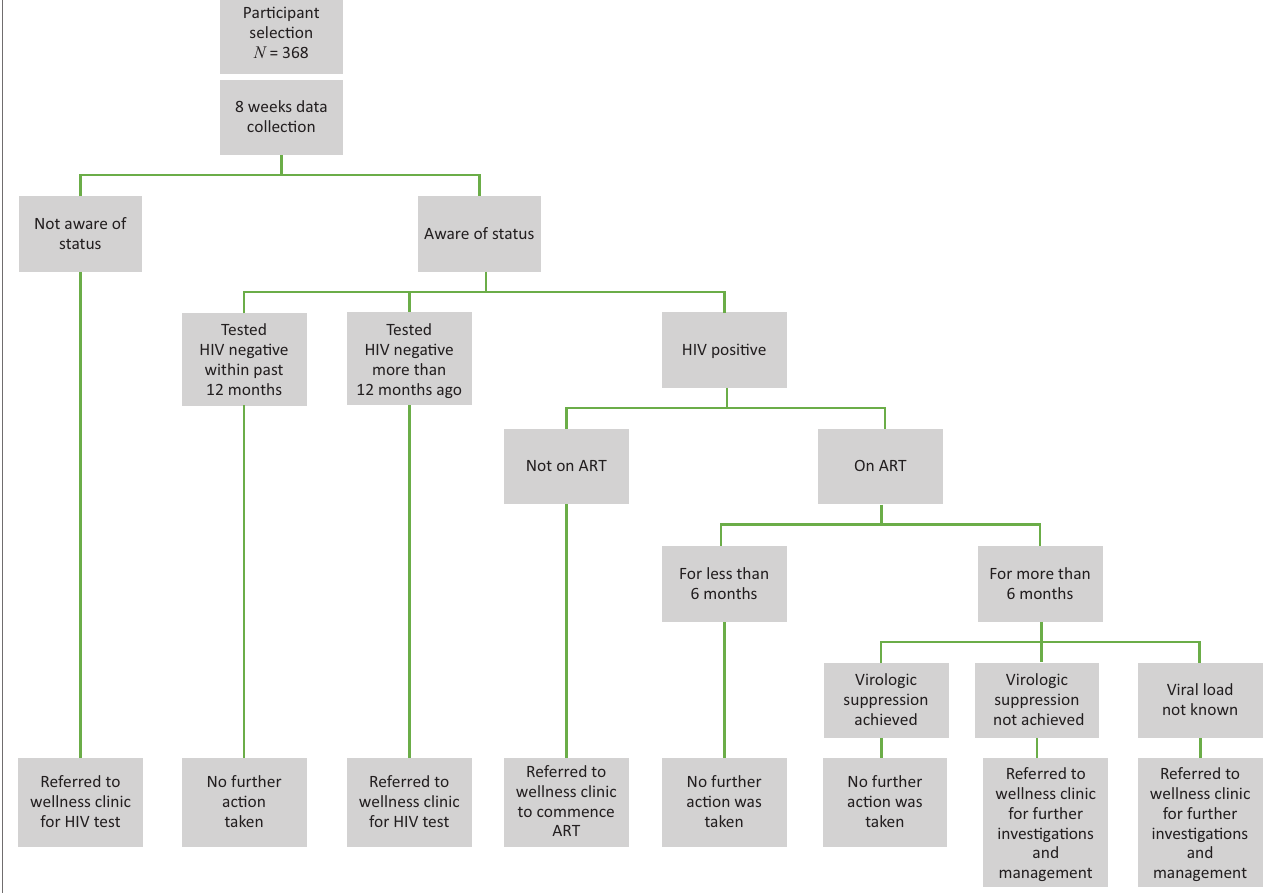
FIGURE 1: Study procedure and